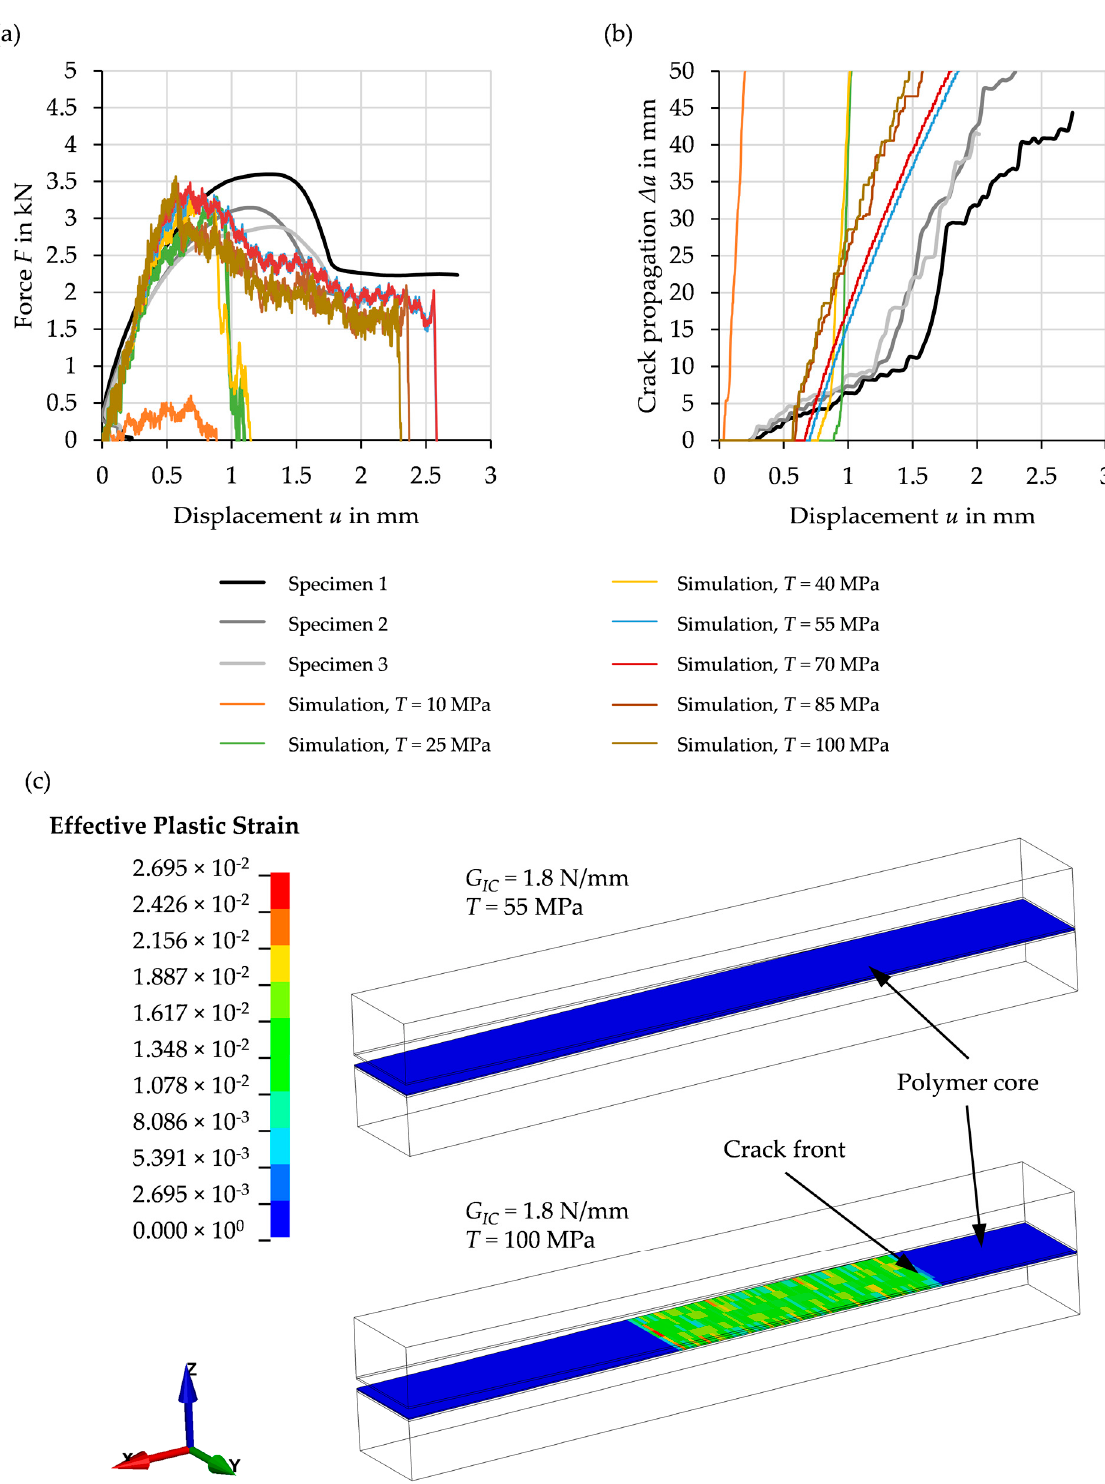
Figure 13. Influence of the normal strength T on the ( a ) force-displacement, ( b ) crack propagation-displacement and ( c ) plasticity behavior of the polymer core, for G IC = 1.8 N/mm.